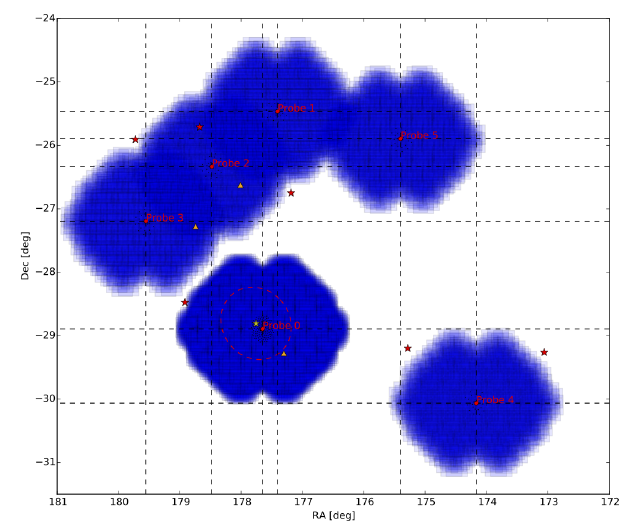
Figure 2. DECam observing strategy for NGC 3923. The yellow star marks the center of NGC 3923 and the red dashed circle indicates the approximate extent of the shell system. Red stars indicate bright foreground stars that we attempted to avoid. Orange diamonds indicate other objects of interest.